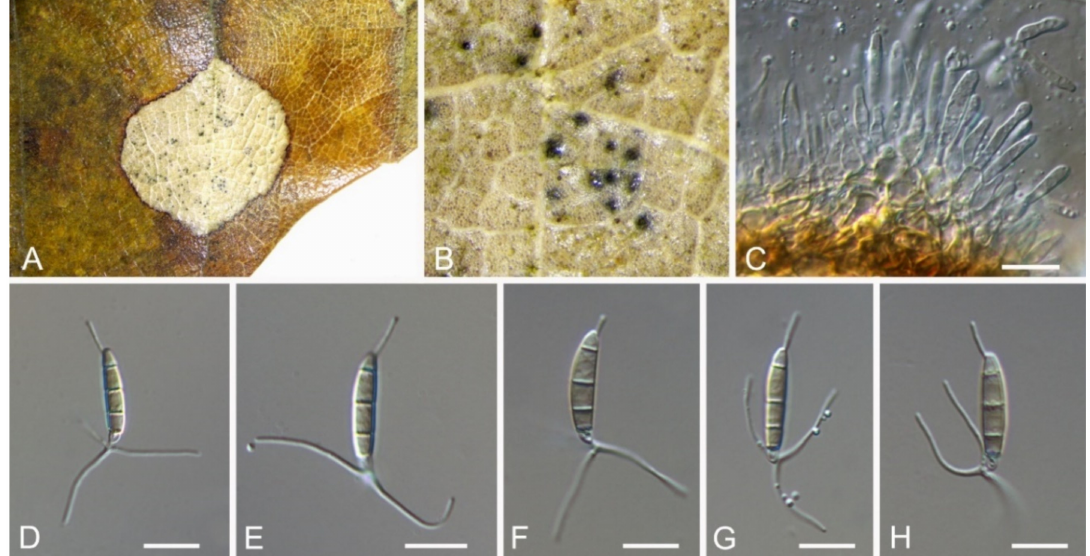
Figure 8. Bartalinia pini (BJFC-S1808). ( A , B ) Conidiomata on the diseased leaves of Castanea henryi ; ( C ) Conidiogenous cells giving rise to conidia; ( D – H ) Conidia. Scale bars: ( C – F ) = 10 µ